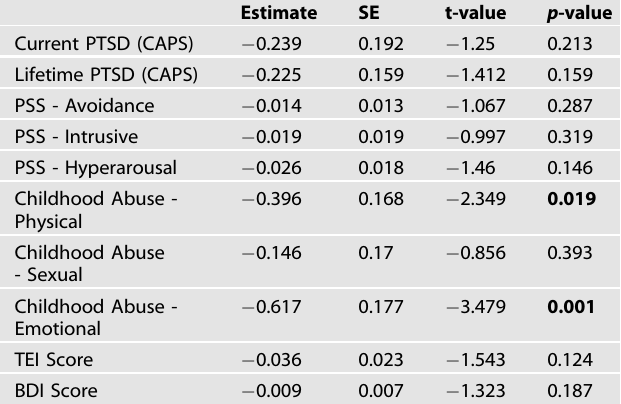
Table 2. Associations between TREC levels and stress-related